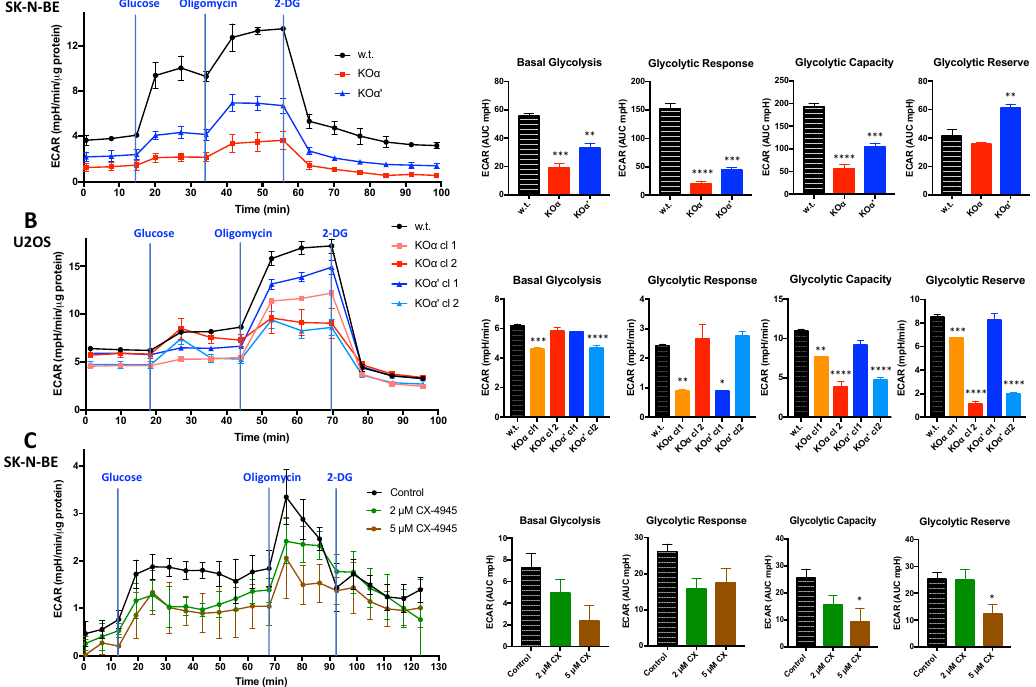
Figure 8. Seahorse glycolytic stress test of w.t. and KO clones of SK-N-BE and U2OS cells. The glycolysis stress tests were performed using a Seahorse extracellular flux analyzer. ECAR (extracellular acidification rate) was monitored following the indicated additions and normalized to protein concentrations. Each experiment was performed at least in quadruplicate. Values are expressed as the mean ± SEM. At least two independent experiments were performed; representative profiles are shown. ( A ) SK-N-BE cells glycolytic stress test profile (left) (KO α clone 1, KO α ’ clone 2) and quantification of the experiment (right), performed with the XF software. ECAR values are expressed in AUC (Area Under Curves) units, quantifying the area of the curves corresponding to the different phases of the experiment (see Section 2). Significance refers to w.t. cells; ( B ) U2OS cells glycolytic stress test profile (left) (w.t. cells or the indicated clones) and quantification of the experiment (right), performed with the Wave software. ECAR values are expressed in mpH/min, as detected at the last measure point of each phase of the experiment (see Section 2). Significance refers to w.t. cells; ( C ) SK-N-BE cells glycolytic stress test profile, upon treatment with vehicle (control) or the indicated concentration of CX-4945 for 5 h before running the Seahorse experiment (left). Quantification of the experiment is shown on the right, performed with the XF software. ECAR values are expressed in AUC (Area Under Curves) units, quantifying the area of the curves under three points of each phases of the experiment (see Section 2). Significance refers to vehicle-treated control cells. (*) p < 0.05, (**) p < 0.01, and (***) p < 0.001, (****) p <